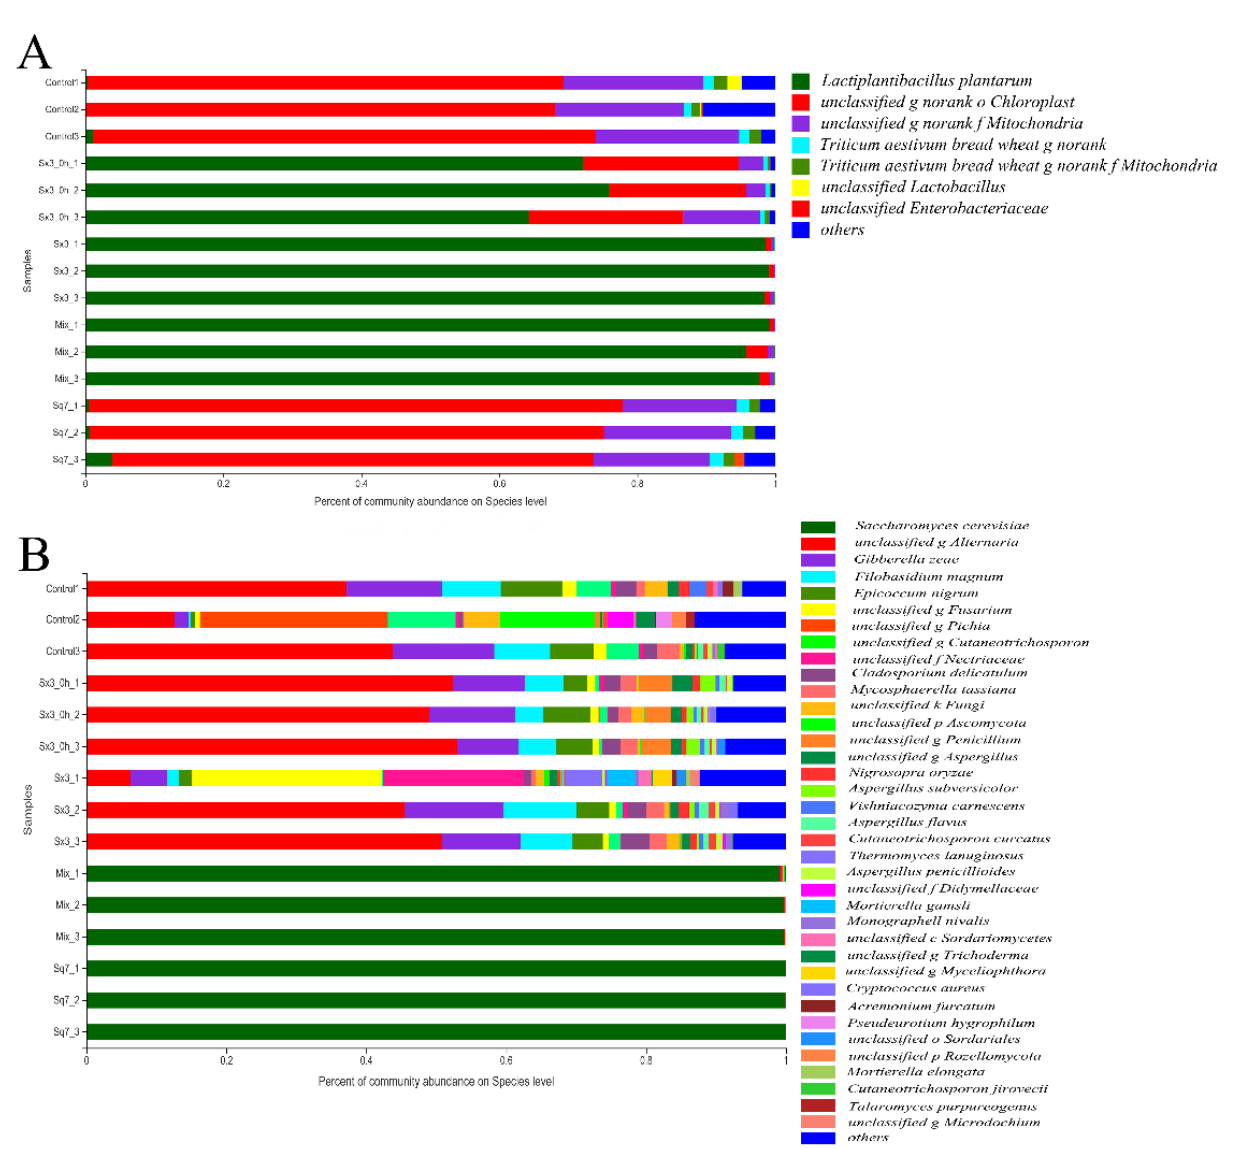
Figure 2. Diversity of bacteria ( A ) and fungi ( B ) in sourdough with 0 h fermentation (Sx3_0 h_1-3) and 6 h fermentation (Control_1-3, Sx3_1-3, Sq7_1-3, Mix_1-3).